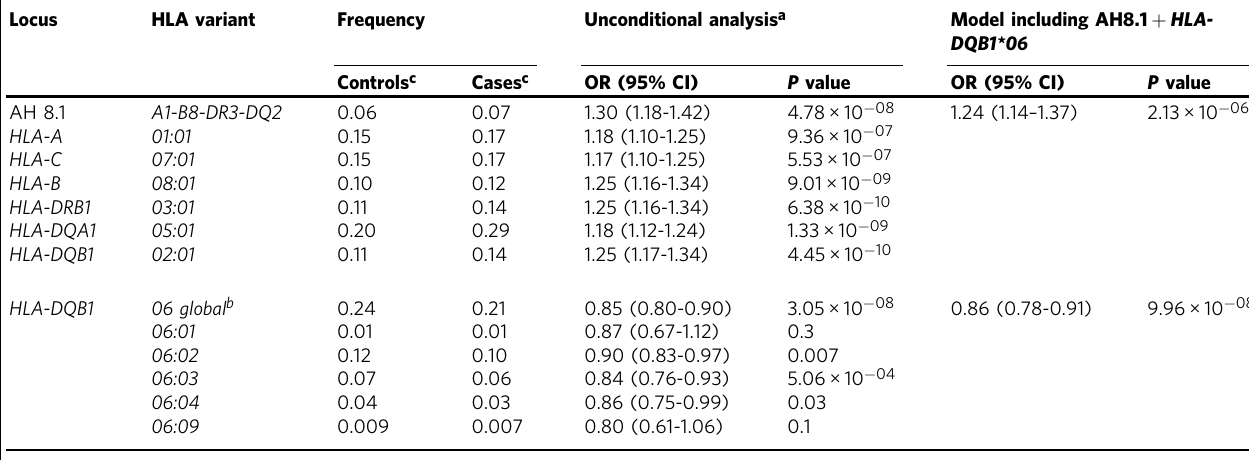
Table 2 Top associations of the HLA alleles with squamous cell carcinoma of European ancestry